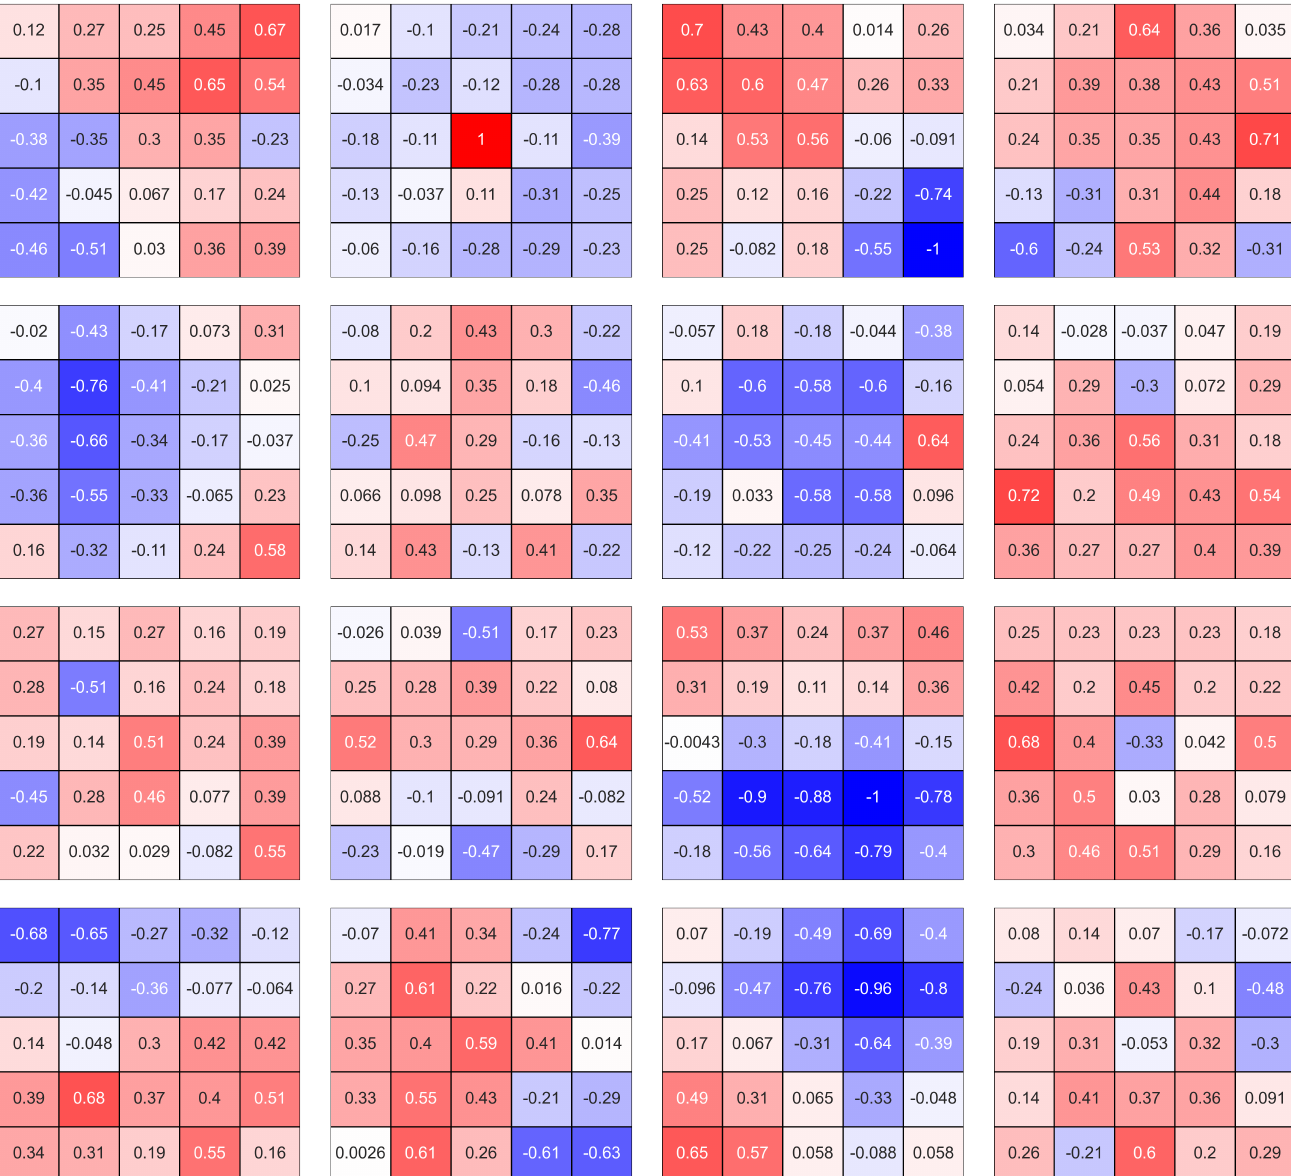
Figure A2. Normalized kernels of 1st layer of Fully CNN with unfiltered